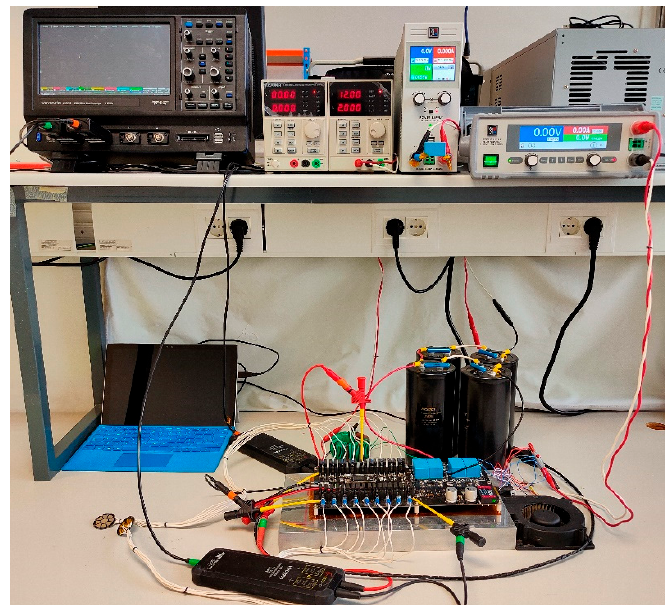
Figure 8. Image of setup used in the experiment.